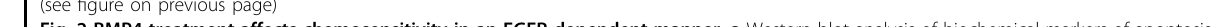
Fig. 2 BMP4 treatment affects chemosensitivity in an EGFR-dependent manner. a Western blot analysis of biochemical markers of apoptosis. Immunoblots show the levels of cleaved caspase 3, caspase 7, and PARP (two exposures) in untreated, BMP4- and/or TMZ-treated glioma spheres. Detection of β -actin ensured equal protein loading. b Densitometric analysis of apoptotic markers ( a ). Quanti fi cations of three (L0125 and L0615) or two (L0512 and L0627) independent experiments are shown. Data are presented as the means ± SD (log-scale). See the legend in Fig. 1f for more details. c Changes in the expression of cell cycle genes induced by BMP4 and/or TMZ treatments in L0125 and L0615 spheres. The heatmap (top) shows changes in the expression of the genes from the ‘ cell cycle ’ Gene Ontology category. Z -scores were computed separately for the two cell lines. An unsupervised clustering led to two main clusters, named cluster 1 and cluster 2, which are highlighted on the right side. The computed clusters showed associations with genes gathered as ‘ regulation of cell cycle G1/S phase transition ’ or ‘ regulation of cell cycle G2/M phase transition ’ Gene Ontology terms (bottom). P -values were computed using Fisher ’ s exact test. The red dotted line marks a P -value = 0.05. d Distribution of cells in cell cycle phases was determined by fl ow cytometry. The left panel presents the results for all cell cycle phases as the means ± 95% con fi dence intervals for the means computed from three independent experiments. P -values shown above the plots were computed using χ 2 tests. The right panel shows the effects of selected treatments (BMP4 alone and BMP4 + TMZ) on the fraction of cells in G1 (top) or G2/M (bottom) phases. The effects are shown by the difference in means and 95% con fi dence intervals for the differences. Yellow and purple colors correspond to the L0125 and L0615 spheres, respectively. The statistical signi fi cance was tested with ANOVA and Duncan ’ s post hoc test. P < 0.05 is written in red. e Western blot analysis of cell cycle-related proteins in untreated and BMP4 ± TMZ-treated spheres. Levels of p21 CIP1 , p27 KIP1 , Cyclin B1, Cyclin D1, and phospho-Rb (Ser807/811) proteins were analyzed. β -actin was used as a loading control. f Densitometry analysis of immunoblots shown in e . Each bar and whisker represent the mean ± SD of two or three independent experiments (log-scale). The horizontal P -value corresponds to the comparison between BMP4- and BMP4 + TMZ-treated cells, which was computed with Duncan ’ s post hoc